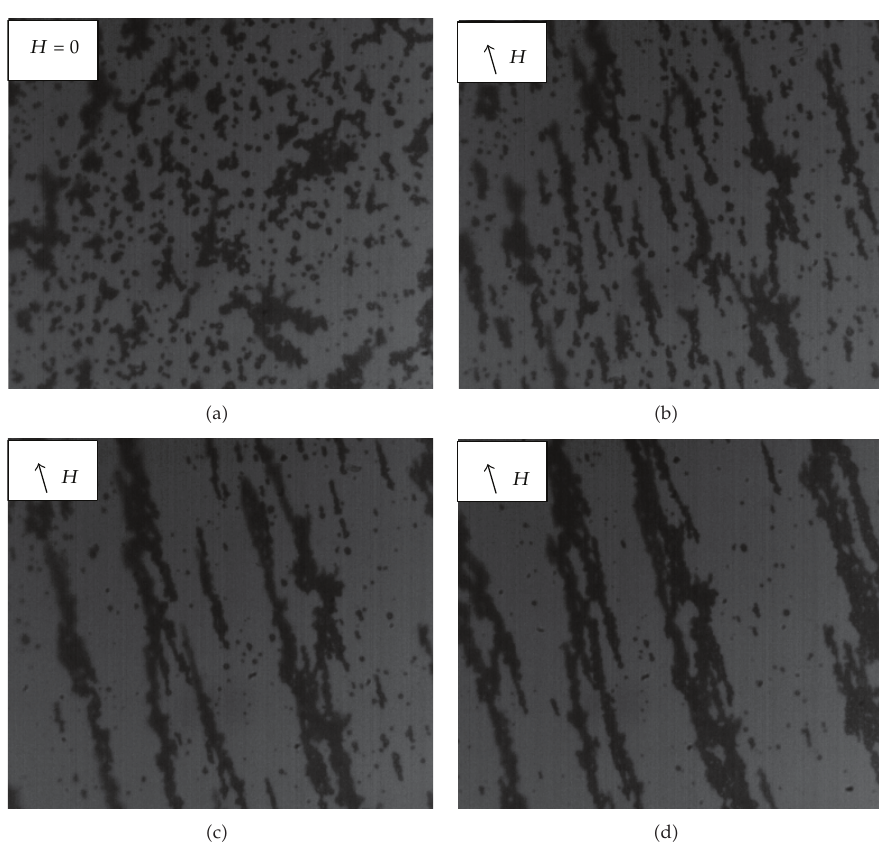
Figure 3: The physics experiment results in di ff erent strength magnetic fields.